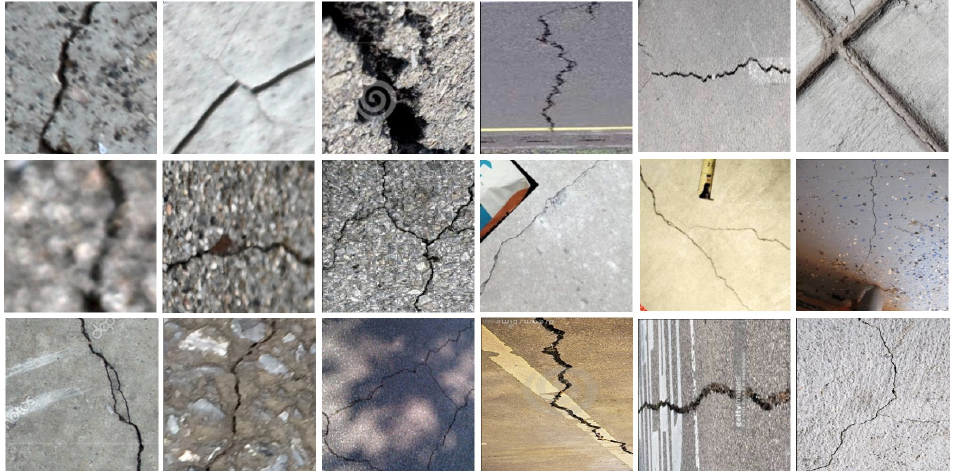
Figure 9. Training dataset